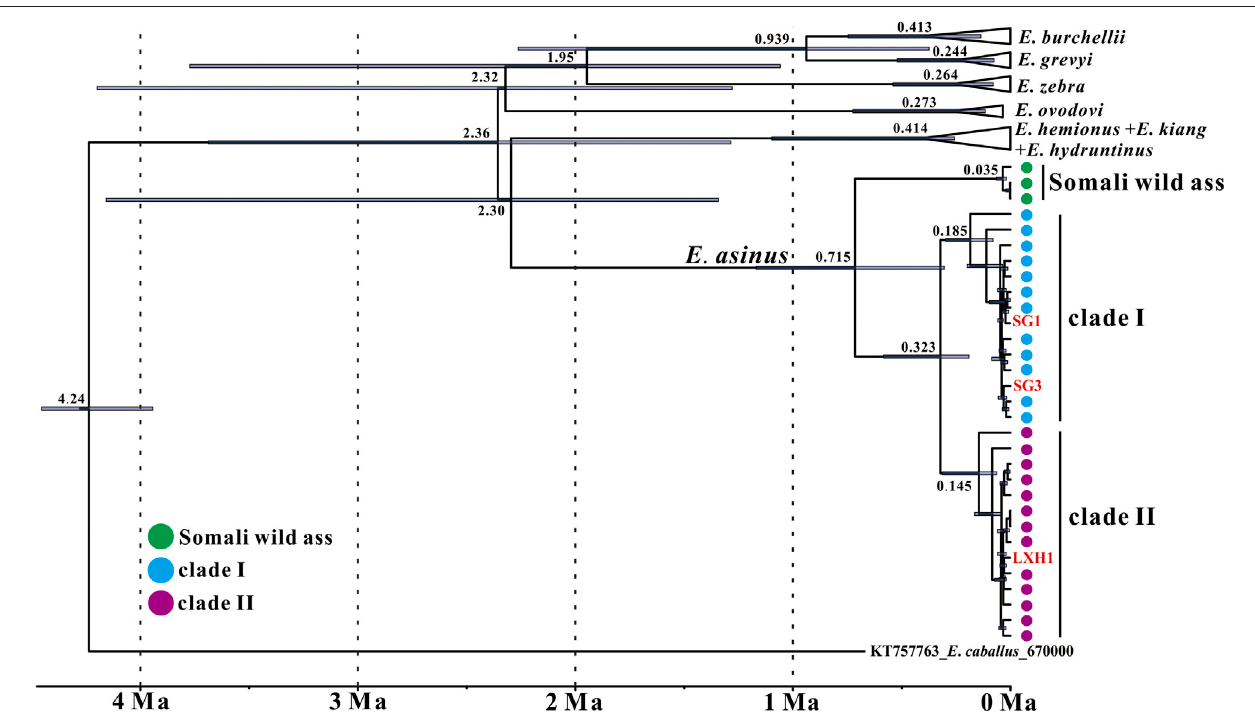
FIGURE 3 | Maximum clade credibility tree of the genus Equus as recovered with BEAST based on near-complete mitochondrial genomes. Node heights are centeredonthemedianposteriorageestimateswithbluebarsshowing95%credibilityintervalsofthedivergencetimes.Tipdatesofsamplesusedinthemolecularclock analysis are listed in Supplementary Table S2